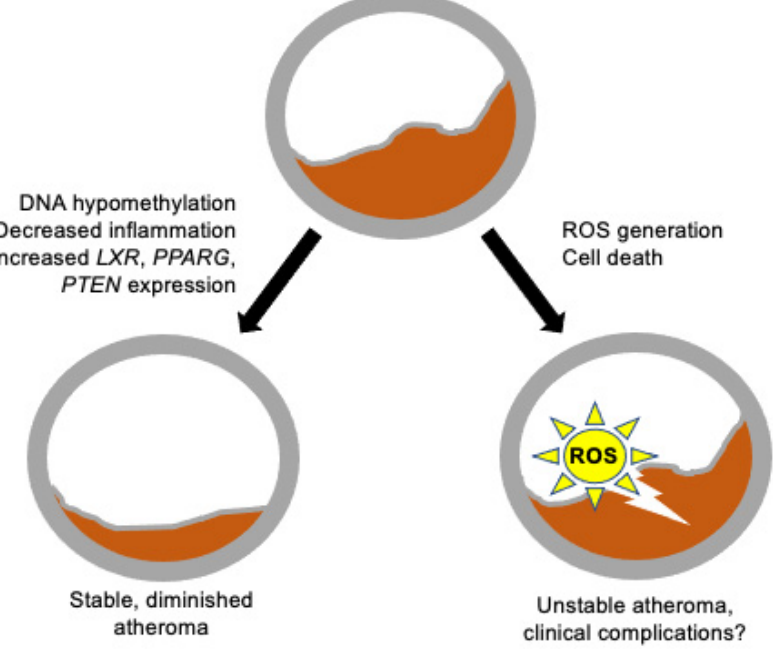
Figure 1. Challenges in NP-based AS therapy. Left, proposed therapeutic strategy consisting of lowering DNA methylation levels close to the ones observed in the unaffected portion of the artery. DNA hypomethylation is accompanied by activation of anti-inflammatory, antiatherogenic gene transcription. Right, cancer therapy-inspired strategy to erode atheroma mass by inducing cell death. The generation of reactive oxygen species (ROS) is presented as an example. Although providing extremely useful insights into mechanism of atherosclerosis, a possible pitfall of strategies aimed at inducing cell death is the risk of atheroma rupture. LXR, liver X receptor; PPARG, peroxisome proliferator-activated receptor gamma; PTEN, phosphatase and tensin